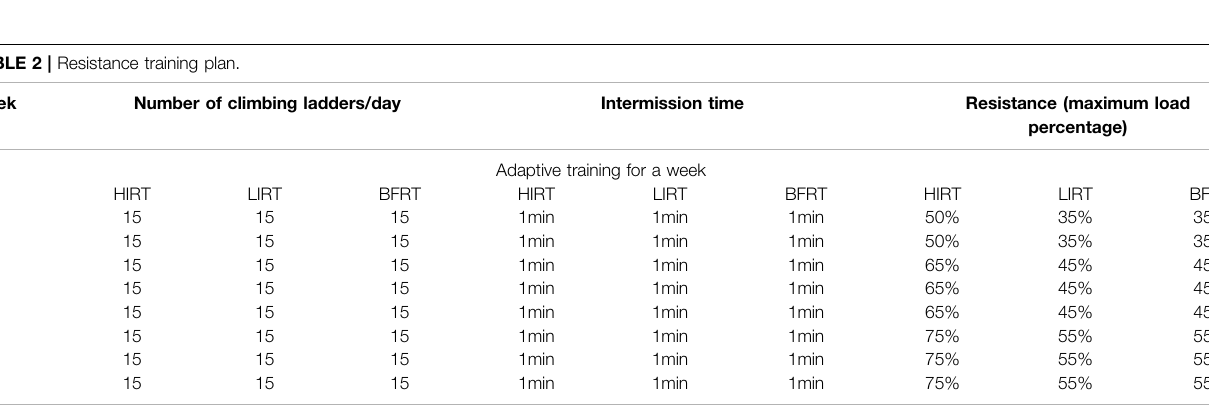
TABLE 2 | Resistance training